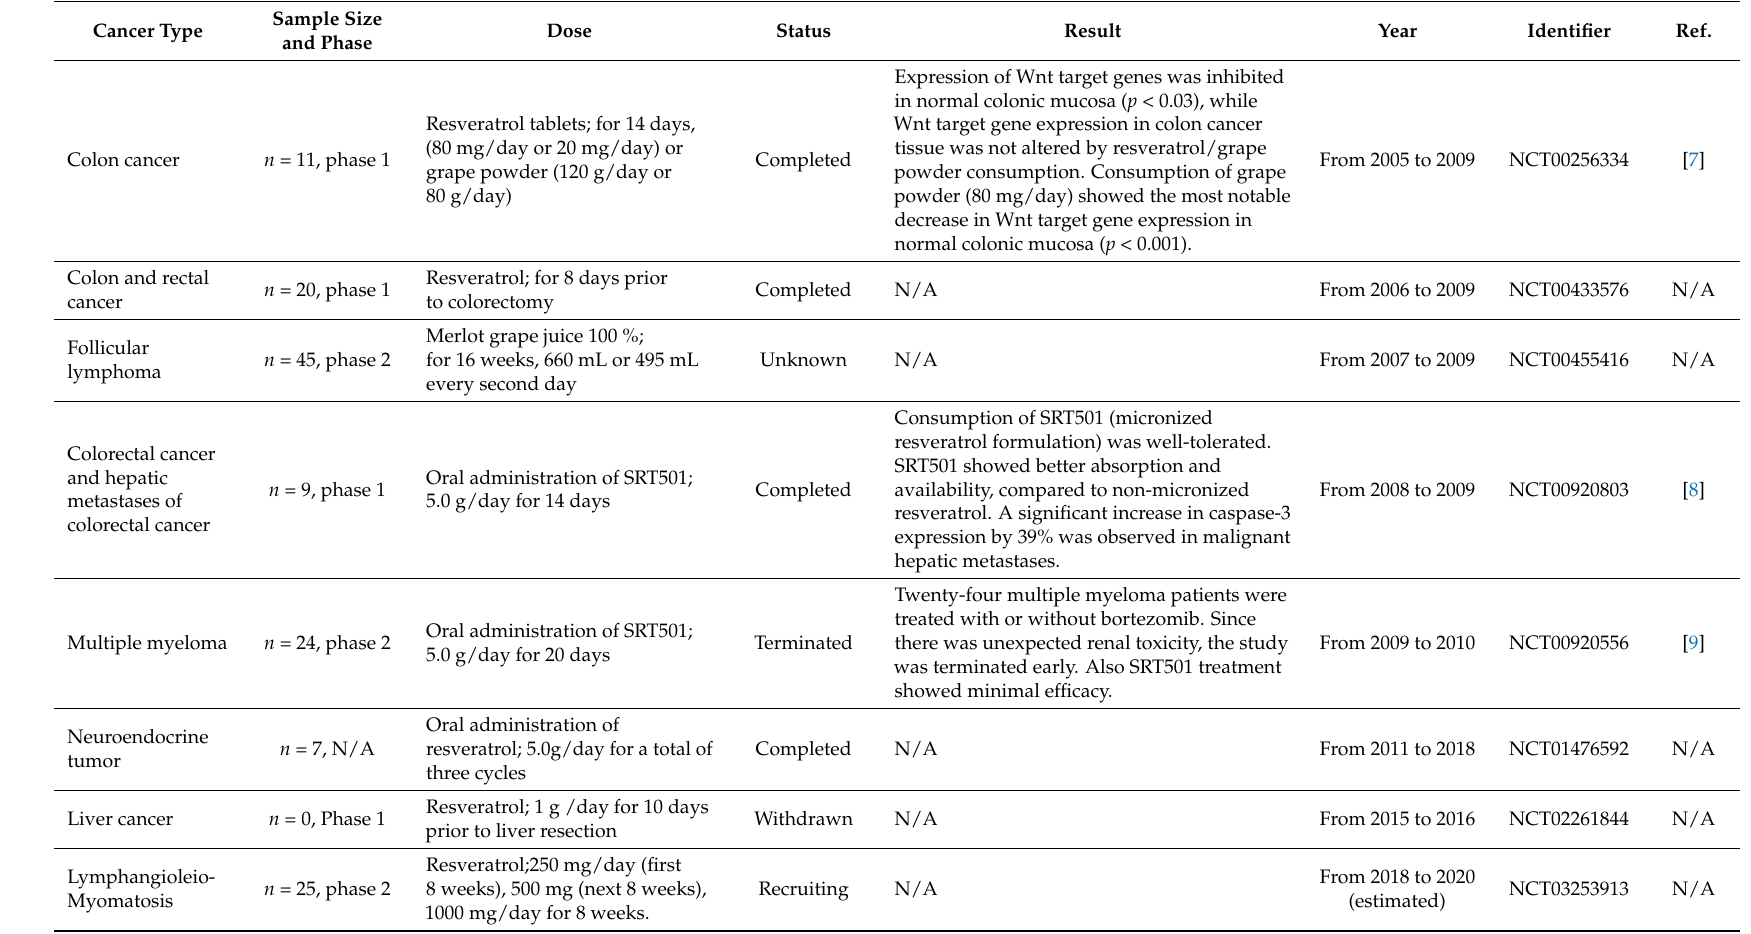
Table 1. Information on resveratrol clinical trials in